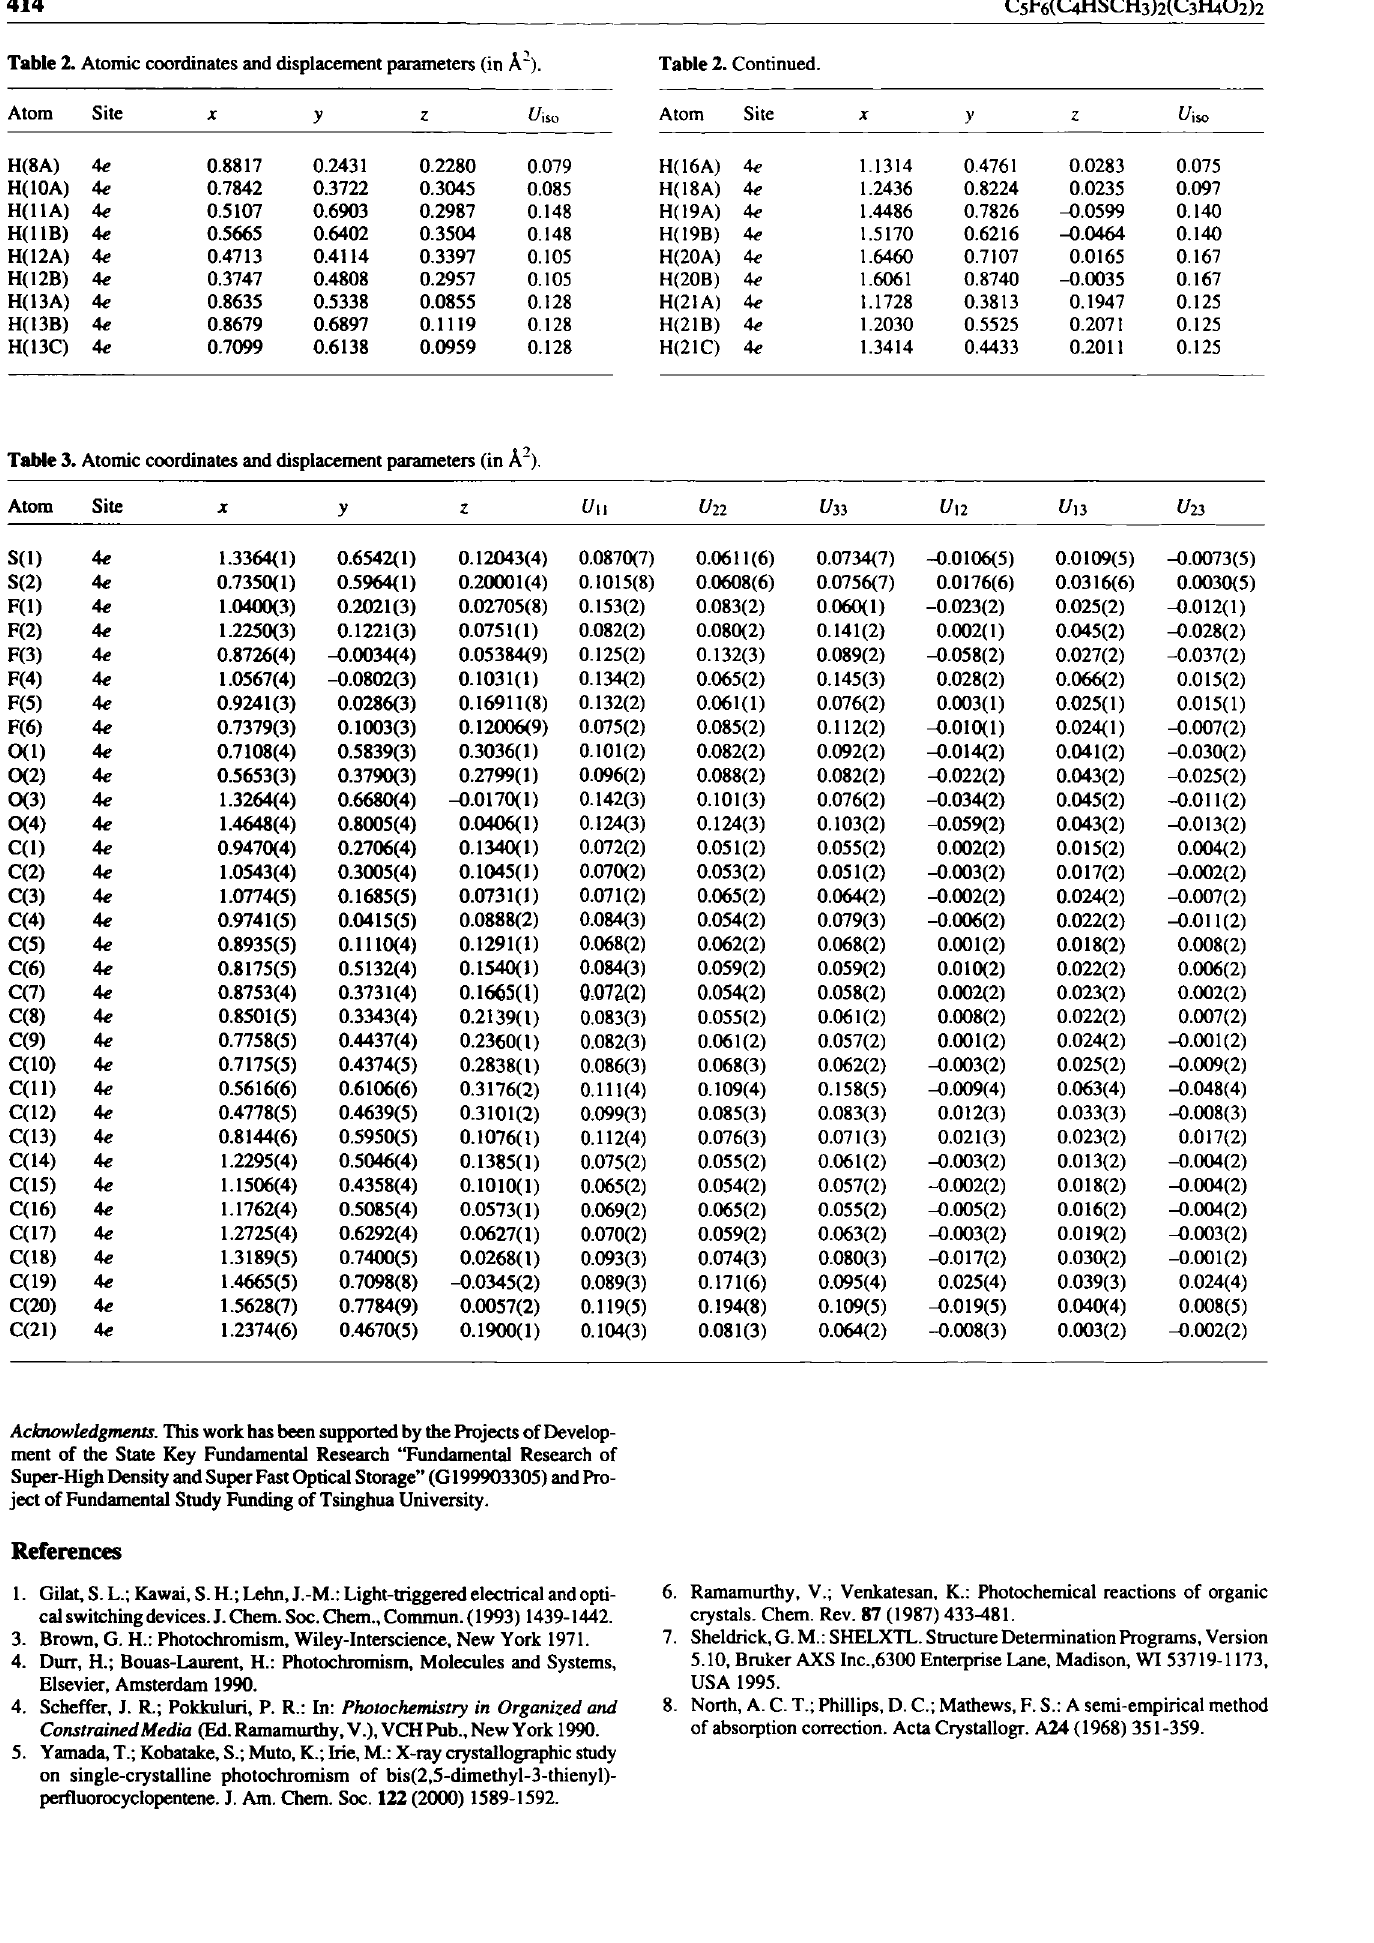
Table 2. Atomic coordinates and displacement parameters (in Â~). Table 2. Continued.